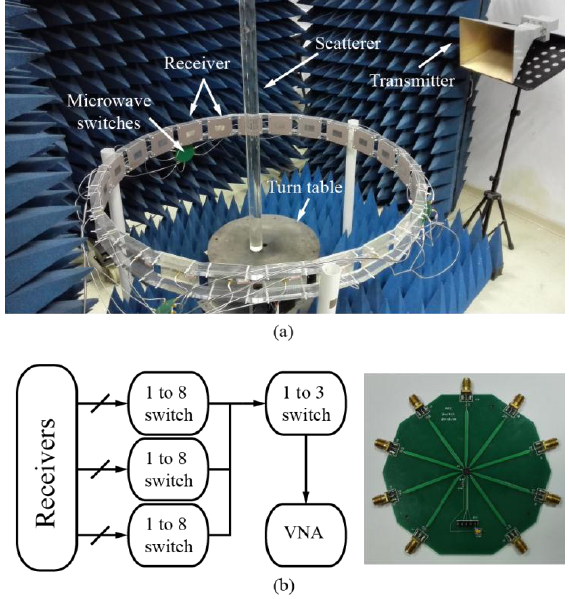
Figure 9. Experimental setup. Inset shows one of the three simple-structured unidirectional microwave switches. ( a ) Experimental setup; and ( b ) simple structured microwave switch.